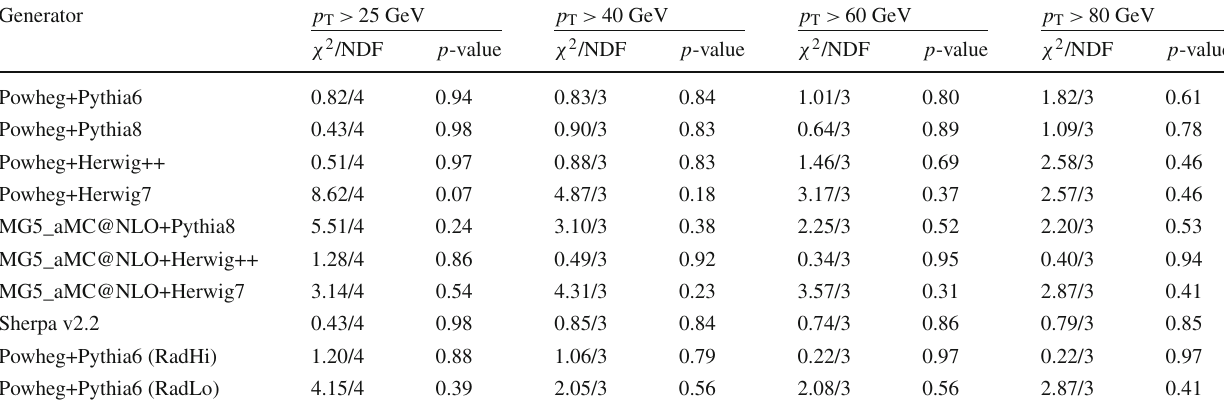
elling uncertainties. “Other” sources of systematic uncertainty refers to lepton and jet selection efficiencies, background (including pile-up jets)